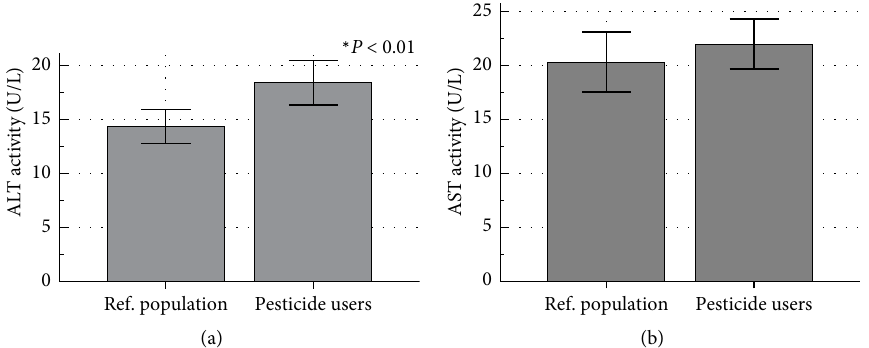
Figure 3: Activities of alanine aminotransferase (a) and aspartate aminotransferase (b) in a reference population and agro pesticide users. ALT: Alanine aminotransferase; AST: Aspartate aminotransferase; Ref. population: Reference population. Significant difference from the reference population at